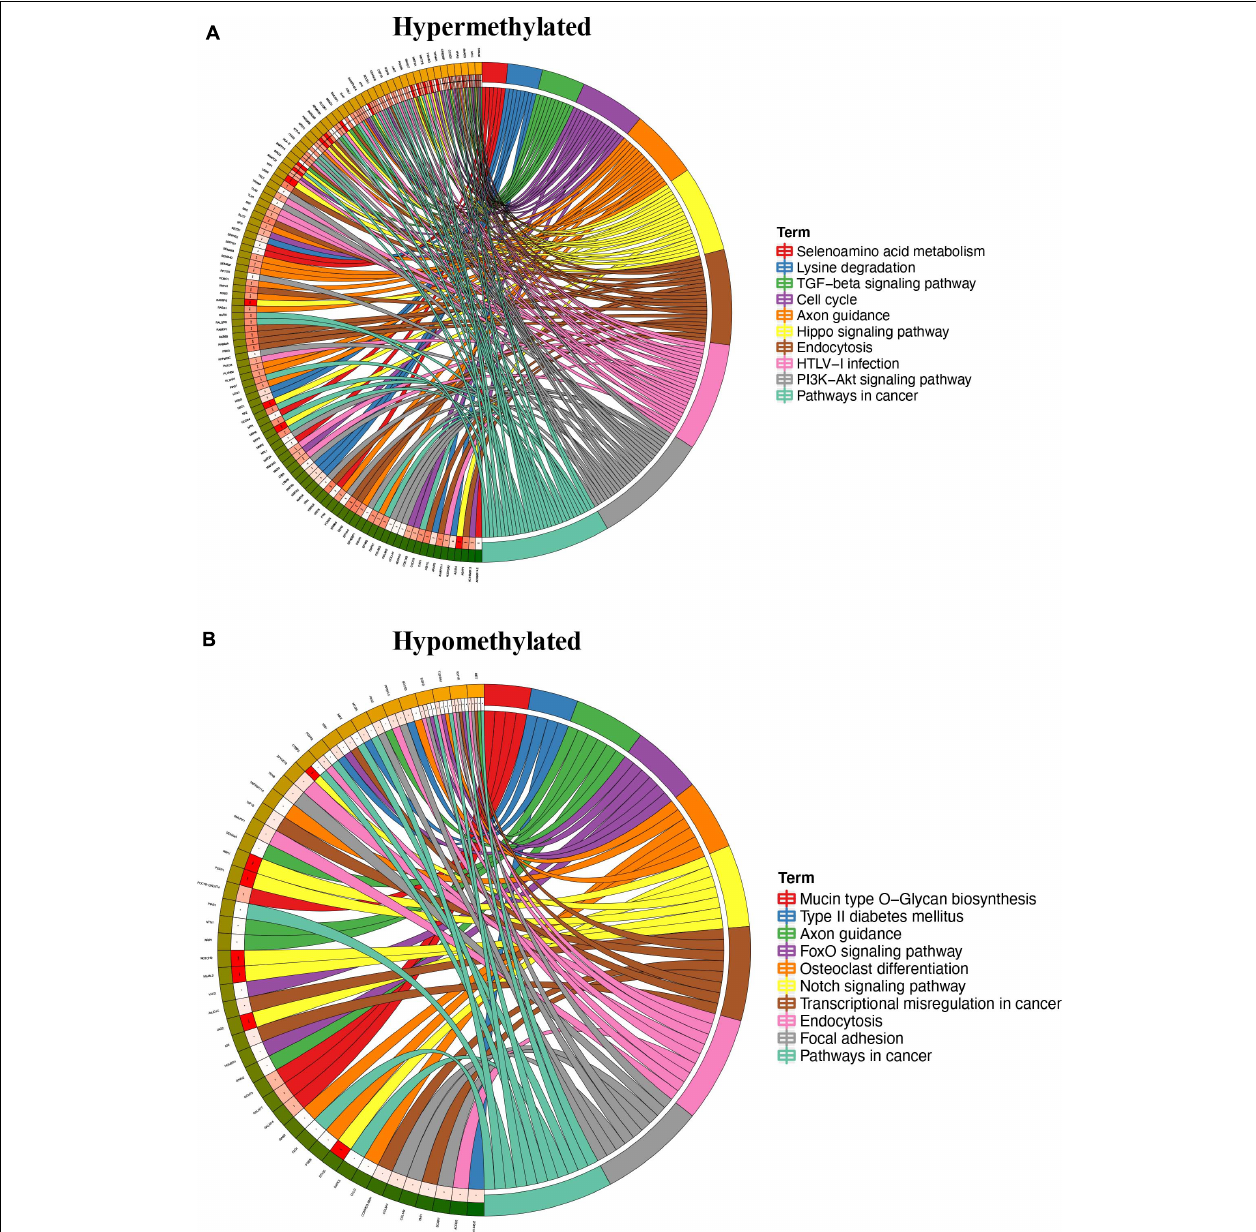
FIGURE 5 | KEGG enrichment analyses of differentially methylated mRNA in pterygium. Top 10 KEGG pathways of genes with (A) upregulated m6A peaks and (B) downregulated m6A peaks. Squares in left semicircle refer to the upregulated or downregulated mRNAs, the squares in right semicircle refer to the pathways. * P < 0.05, ** P < 0.01, *** P < 0.001, genes compared to